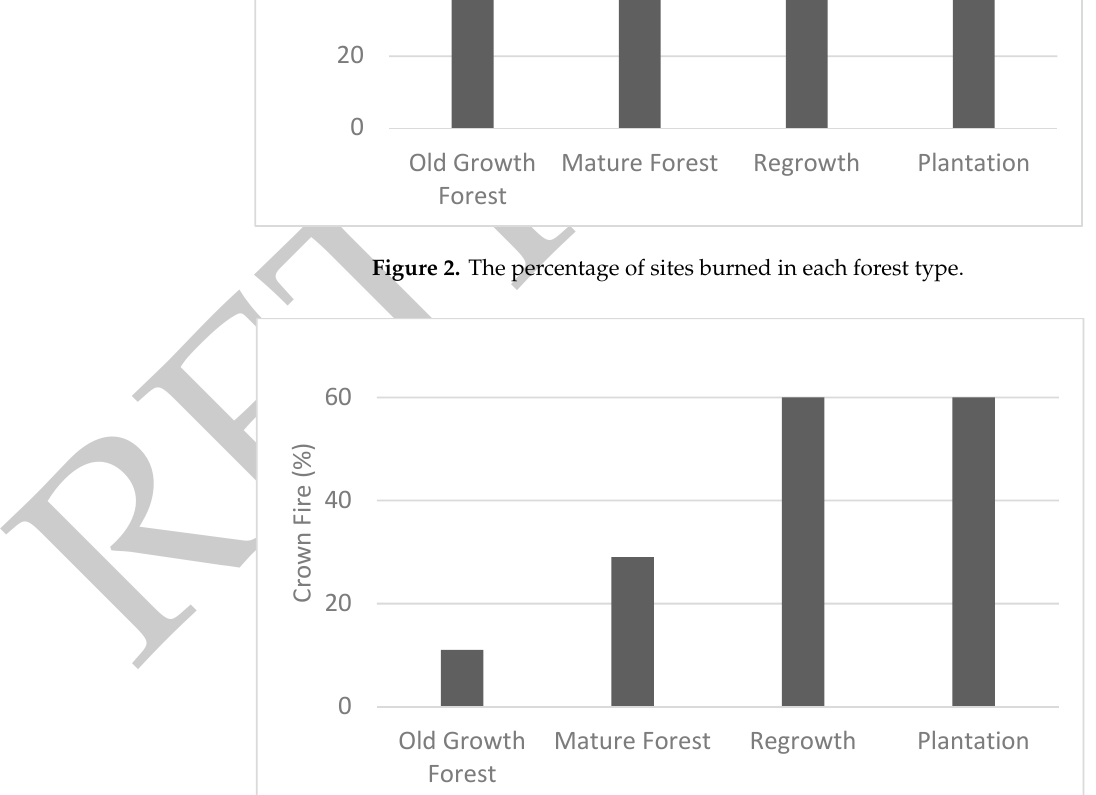
Figure 2. The percentage of sites burned in each forest type.